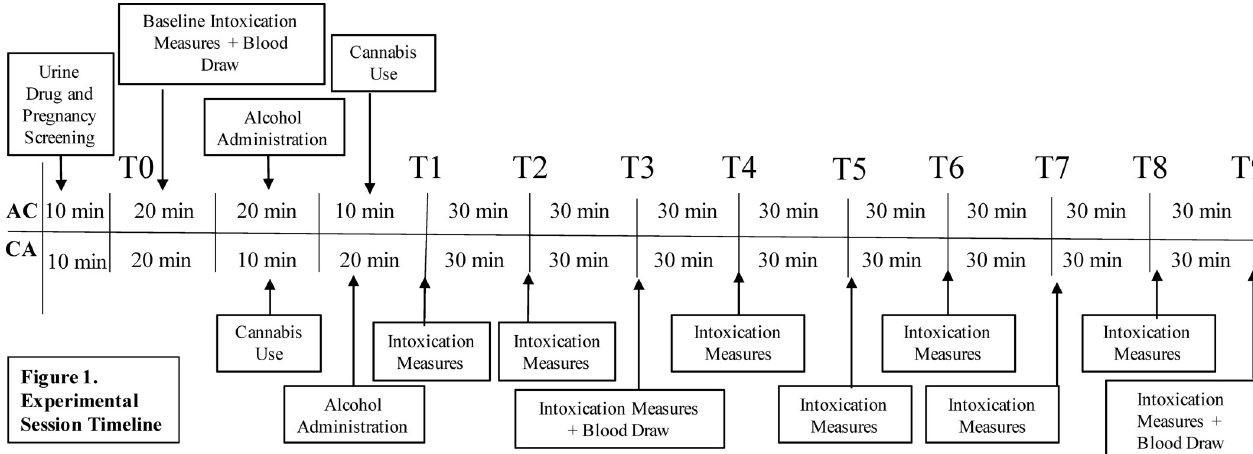
Fig 1. Experimental timeline. Detailed experimental session timeline for individuals completing the session in order AC (alcohol before cannabis) and CA (cannabis before alcohol). The “Intoxication Measures” completed at T0-T9 include BrAC, heart rate, subjective effects of alcohol, drug effects, measures of emotion and the Druid